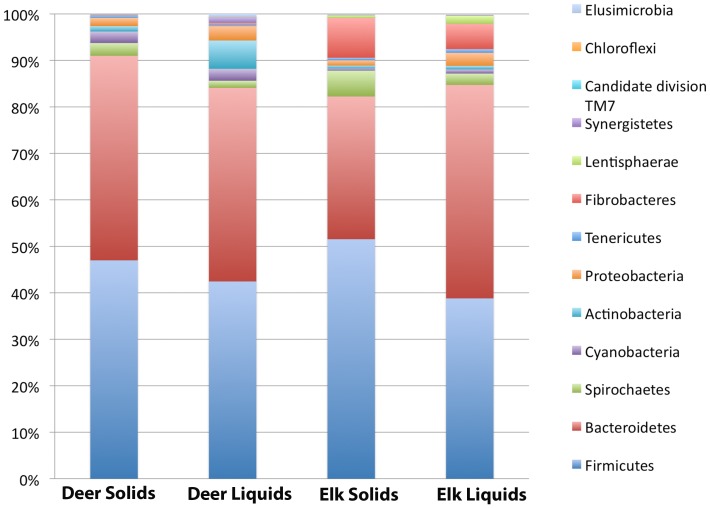
Phylum level comparison of rumen microbiome associated with solid and liquid rumen phase from white tailed deer (n = 3) and elk (n = 15).Values shown represent the percent of sequences assigned to a particular phylum averaged over all samples of the same type.